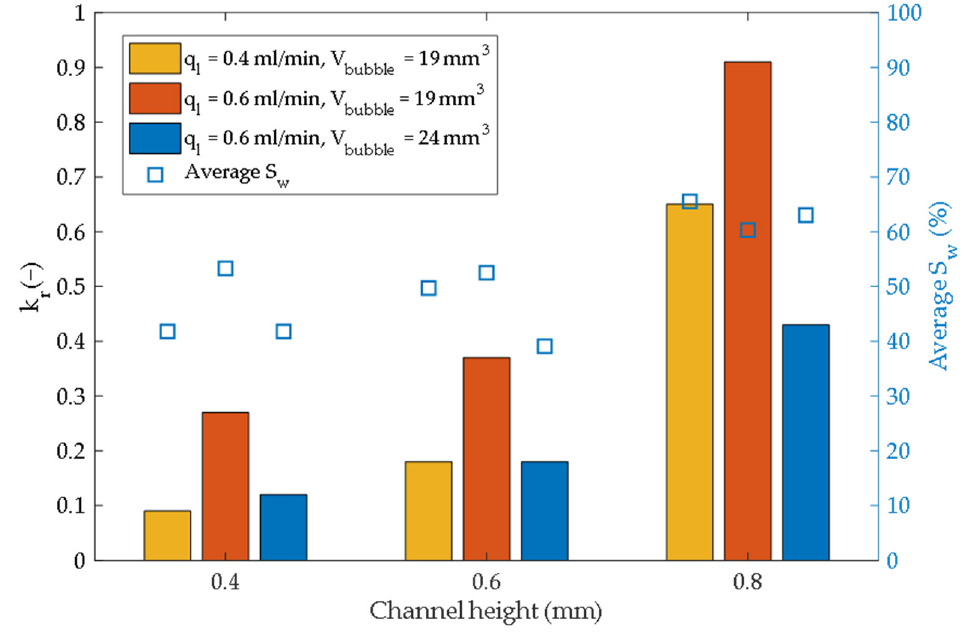
Figure 9. The relative permeabilities (k r ) and average water saturation (S w ) for each channel and flow combination.